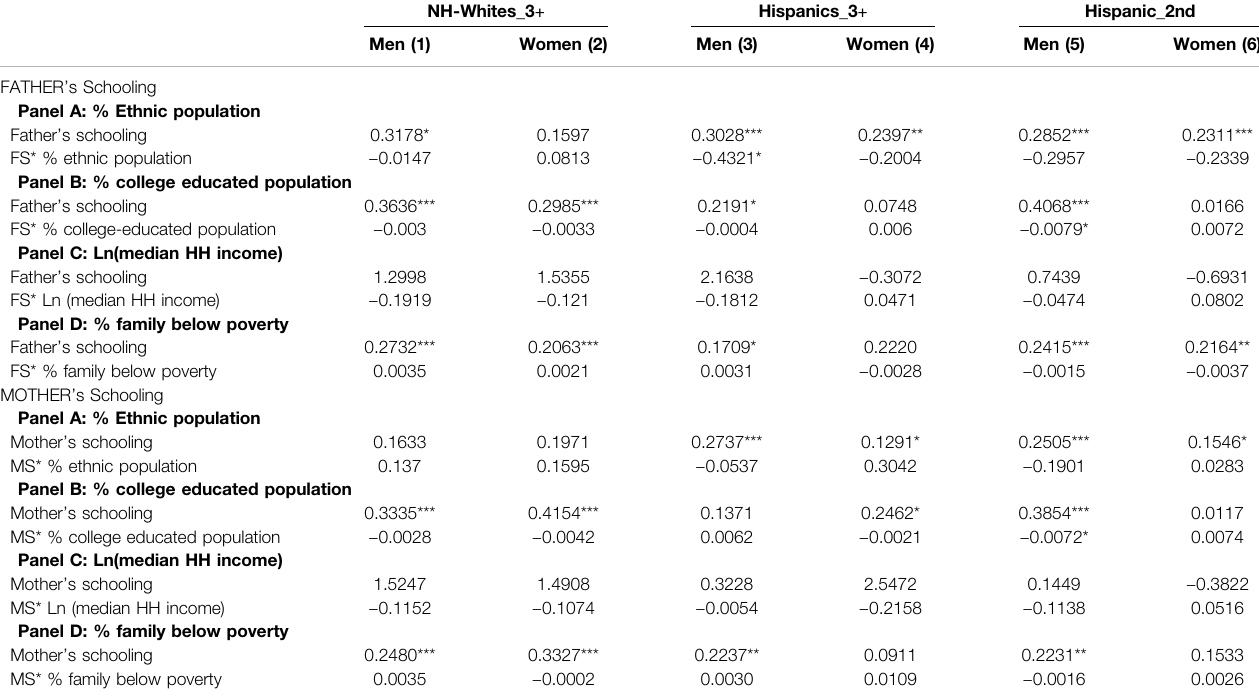
TABLE 3 | OLS Regression results of schooling years.